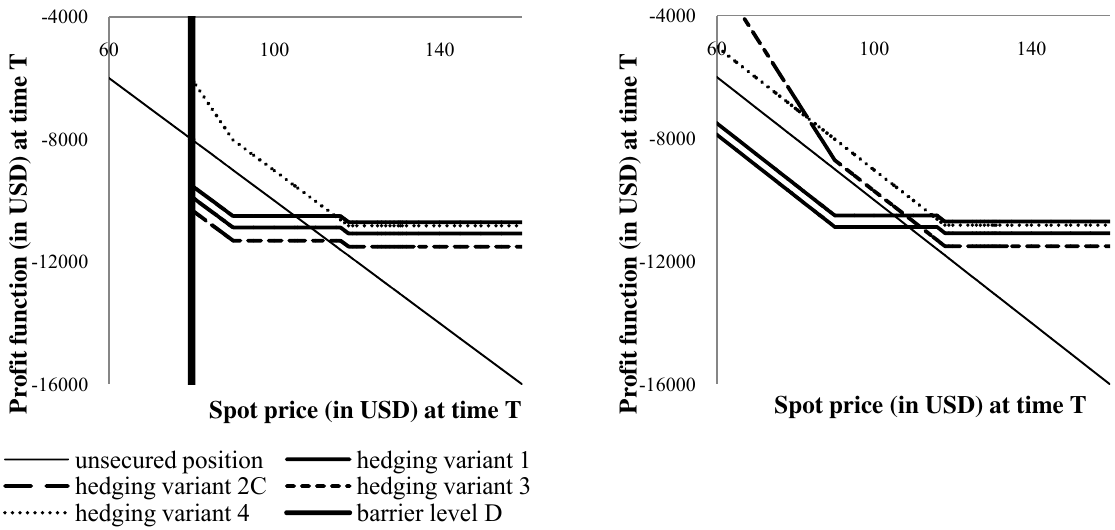
Fig. 2. Comparison of selected designed hedging variants if the upper and lower barrier was